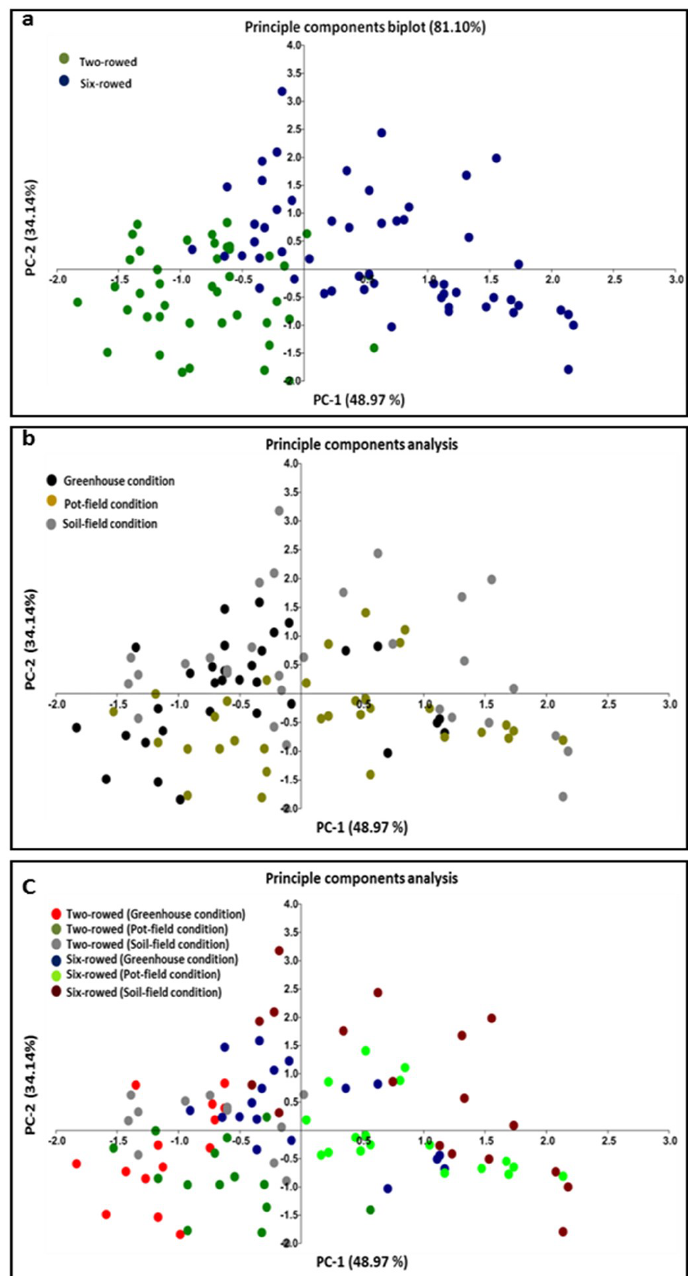
Figure 1. Principal component analysis (PCA) based upon phenotypic data using leaf area (LA), leaf dry weight (LDW), and leaf mass area (LMA) per main culm at the heading stage. PCA for row-types, green and blue color denotes two- and six-rowed barley, respectively ( a ), and for growth conditions, black, greenish-brown and gray color denotes for greenhouse (GH), pot- and soil-field, respectively ( b ), and row-types within growth conditions ( c ), the light-red and dark-blue circles indicate two- and six-rowed plants, respectively, under GH conditions; the green and light green circles indicate two- and six-rowed plants, respectively, under pot-field conditions; and the gray and dark-red circles indicate two- and six-rowed plants, respectively, under soil-field conditions. The number of dots ( n = 54, 18 accessions × 3 growth conditions) for six-rowed and ( n = 42 accessions, 14 × 3 growth conditions) for two-rowed